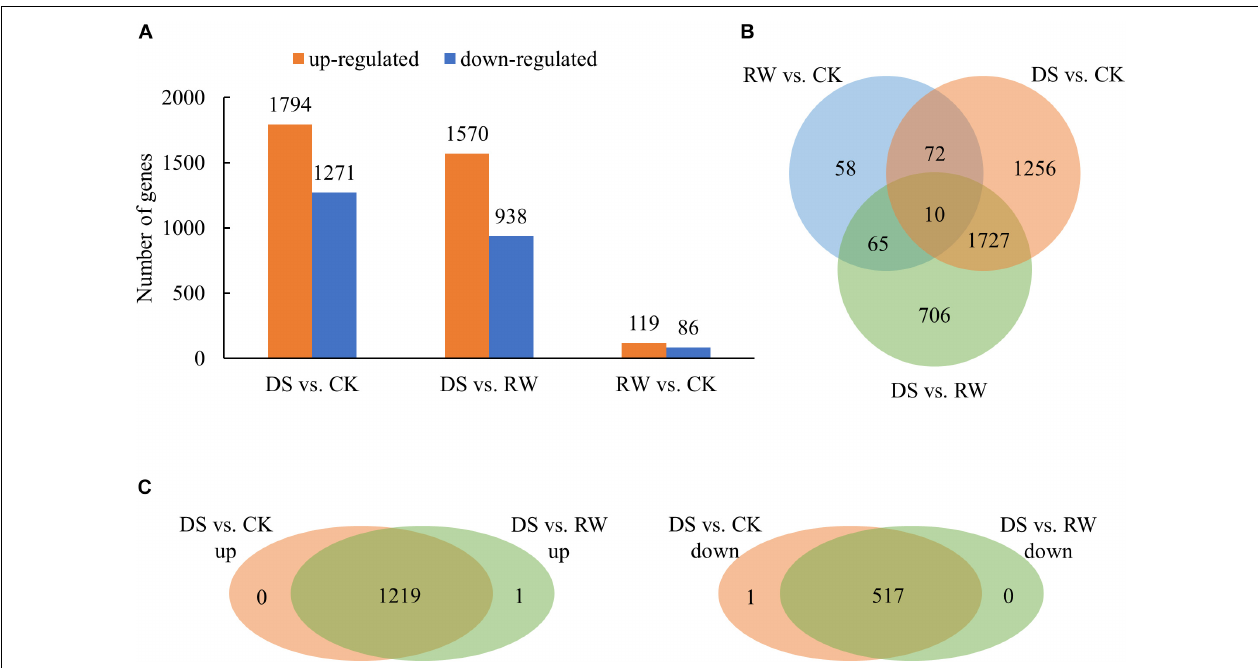
Frontiers in Plant Science |